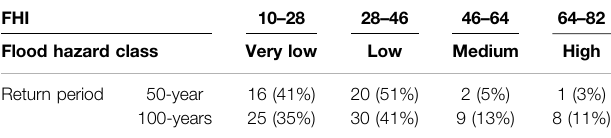
TABLE 11 | Number of buildings in each fl ood hazard class.